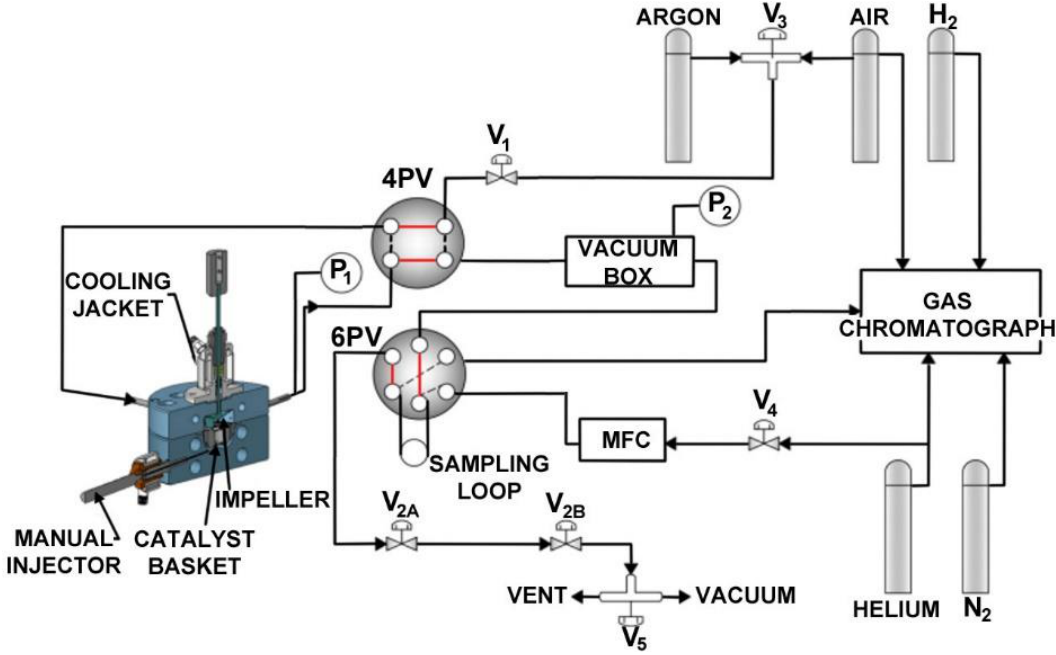
Figure 3. Schematic Description of the 1992-CREC Riser Simulator Including 4PV and 6 PV Valves, Vacuum Box and Gas Chromatographic (GC) Unit [13]. Codes: V 1 , V 2A , V 2B ,V 3 , V 4 refer to auxiliary system on-off values, while P 1 , P 2 refer to the location of pressure gauges. Adapted with permission Ref. [13], Copyright: 2013, Copyright owner’s R. Quddus.